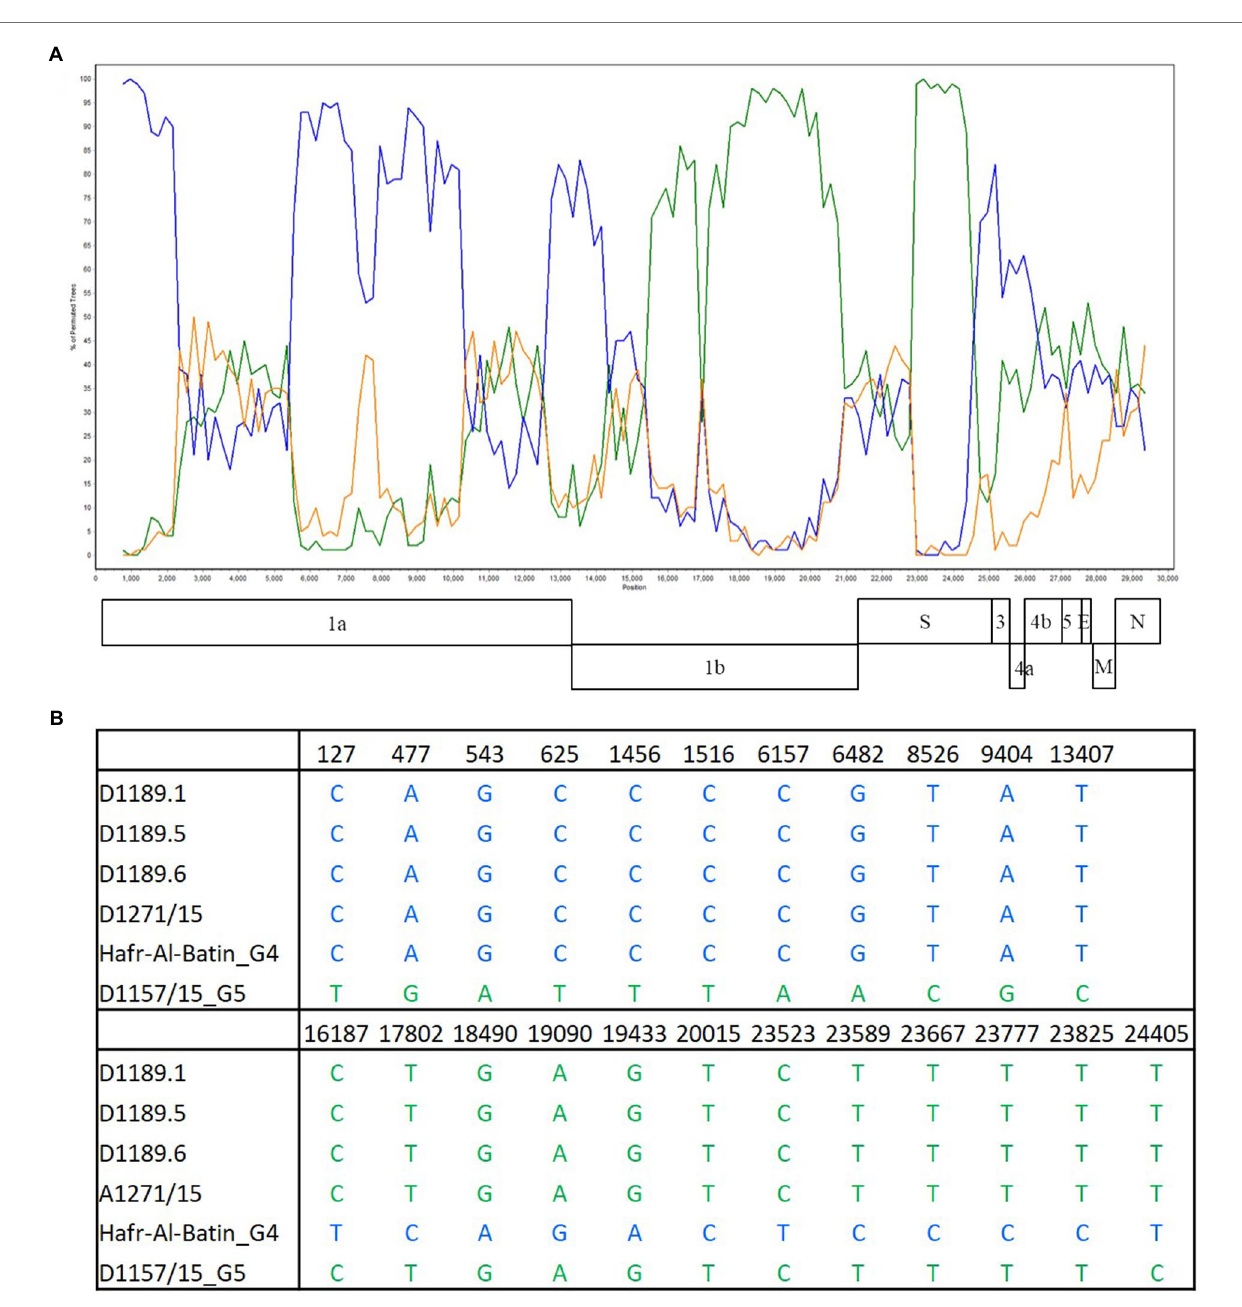
FIGURE 3 | Detection of potential recombination by (A) bootscan analysis and (B) multiple sequence alignment. Bootscan analysis was conducted with Simplot version 3.5.1 (Maximum-likelihood; F84 model; window size 1,500 bp; and step 200 bp) on a gapless nucleotide alignment. D1189.1, D1189.5, D1189.6, and D1271 were selected as the query sequences and compared with the genome sequences of a lineage 4 MERS-CoV strain Hafr-Al-Batin (blue, KF600628), a lineage 5 MERS-CoV strain D1157/15 (green, KX108944), and a lineage 1 MERS-CoV strain UAE/Abu Dhabi_UAE_9 (orange,